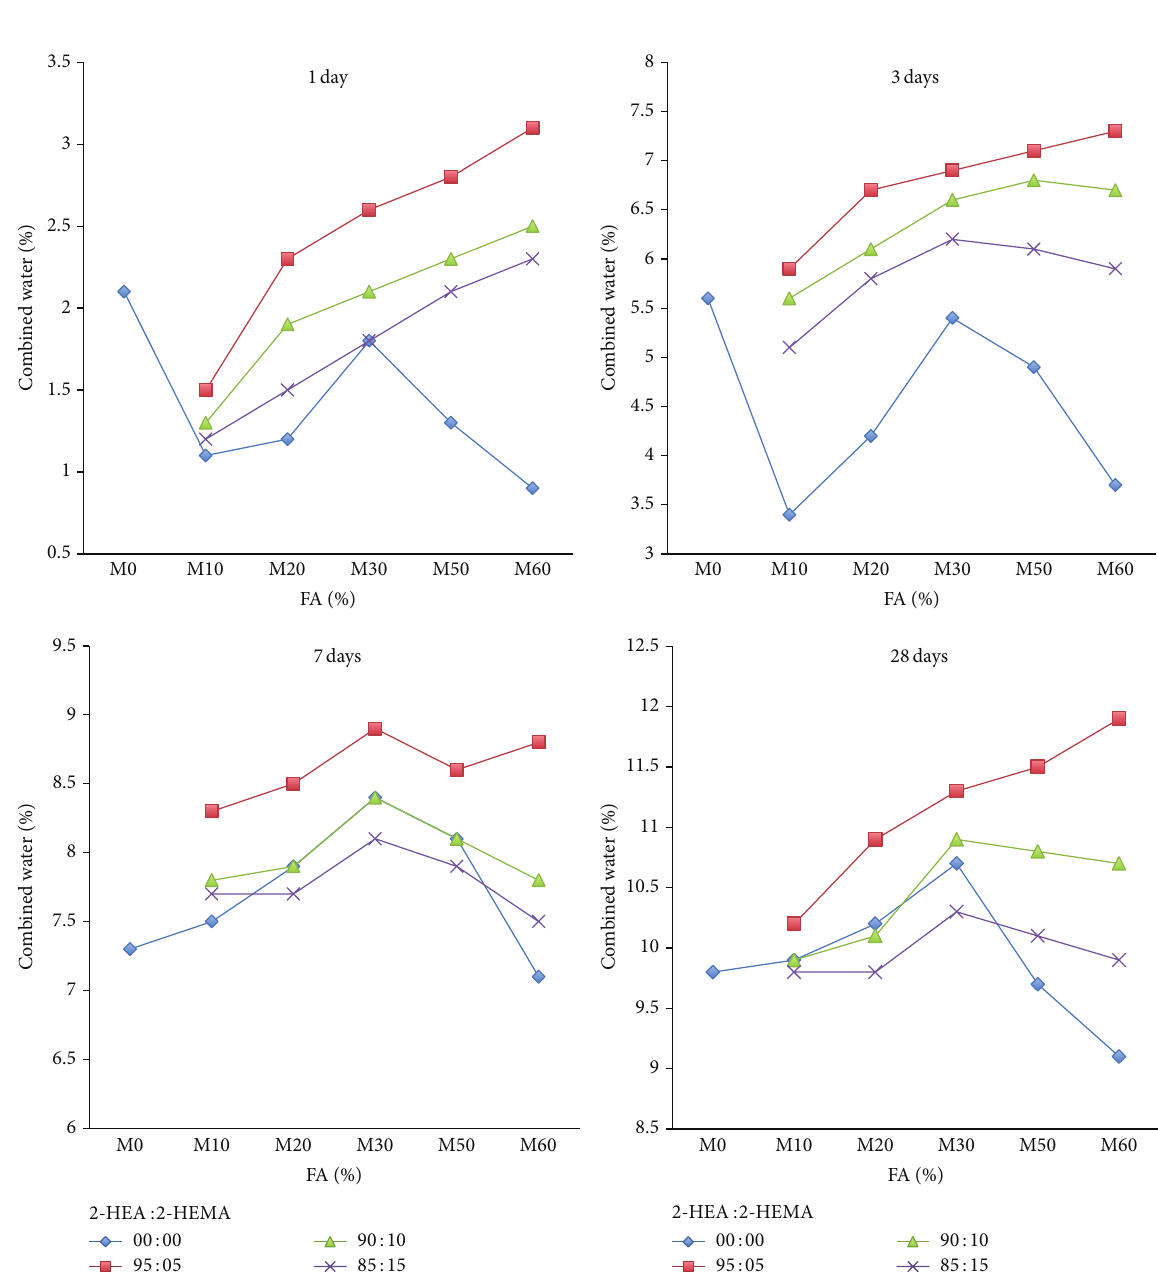
Figure 10: The effect of FA on combined water content of mortar mixes in presence of